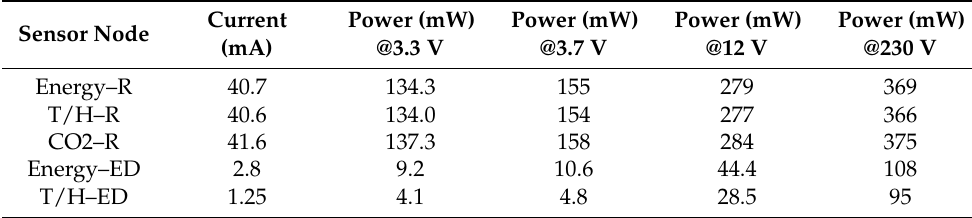
Table 1. Power consumption of sensor nodes for different types of power supply.